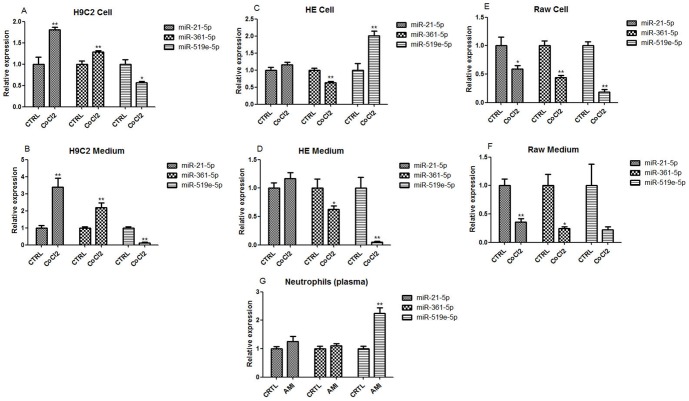
The expressions of miRNAs in cardiomyocytes, endothelium, macrophages, and their medium in condition of hypoxia.Cobalt chloride was used for inducing hypoxia. After 24 hours treatment, cells and medium were collected for detecting the expression of miRNAs, respectively. (A) The expression of miRNAs in cardiomyocytes (H9c2) under hypoxia; (B) The expression of miRNAs in medium of cardiomyocytes (H9c2) under hypoxia; (C) The expression of miRNAs in endothelium (HE) under hypoxia; (D) The expression of miRNAs in medium of endothelium (HE) under hypoxia; (E) The expression of miRNAs in macrophages (Raw 264.7) under hypoxia; (F) The expression of miRNAs in medium of macrophages (Raw 264.7) under hypoxia; (G) The expressions of circulating miRNAs in peripheral blood neutrophils isolated from AMI patients and healthy subjects. Data are presented as mean ± SEM, *p<0.05, **p<0.01 versus control.